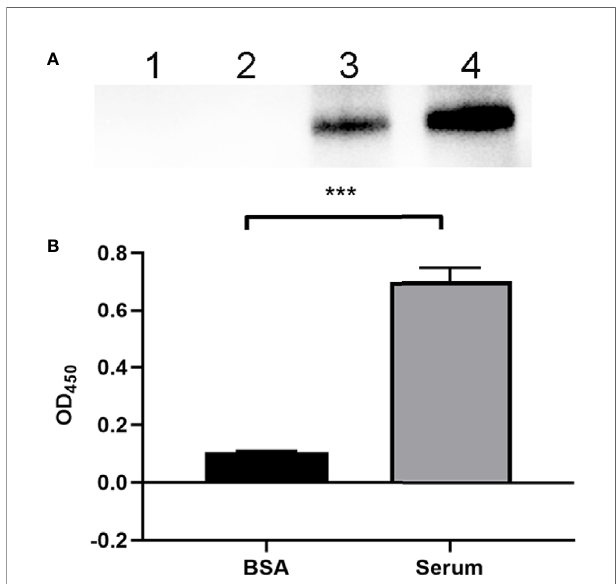
FIGURE 1 | Identi fi cation of the FH-binding ability of ExPEC. (A) Western blotting to detect the ability of ExPEC to bind FH. ExPEC strain RS218 was incubated with 10% human serum or BSA. The bacteria, the last washing buffer, and human serum were analyzed by Western blotting. Lane 1, the bacteria after incubated with BSA (negative control); lane 2, the last washing buffer; lane 3, the bacteria after incubated with human serum; and lane 4, the human serum. (B) Whole-bacteria ELISA assay to detect the binding of FH after ExPEC incubated with human serum. ExPEC incubated with BSA acted as the negative control. Data are expressed as the mean ± SEM of three independent experiments. Statistical analysis was performed using the unpaired t test (*** p <